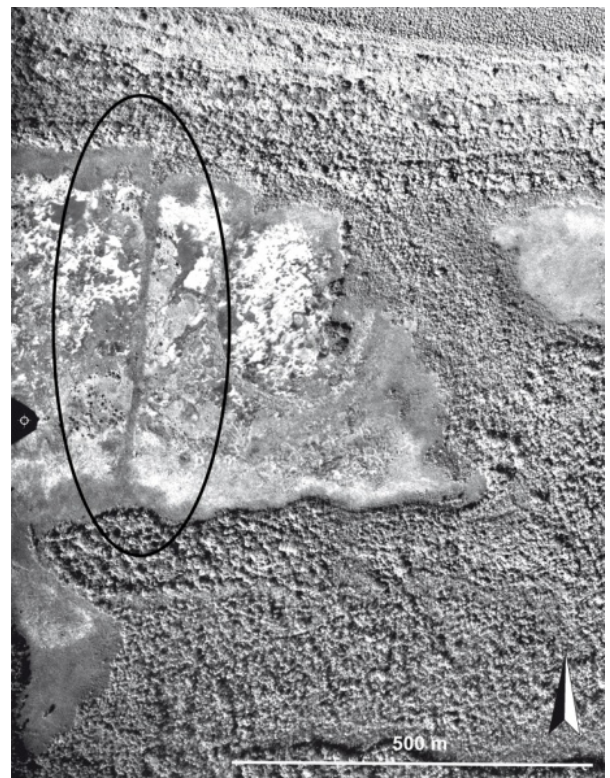
Figure 13. Causeways ( see circled area) crossing a flooded area near Kourou (photo IGN